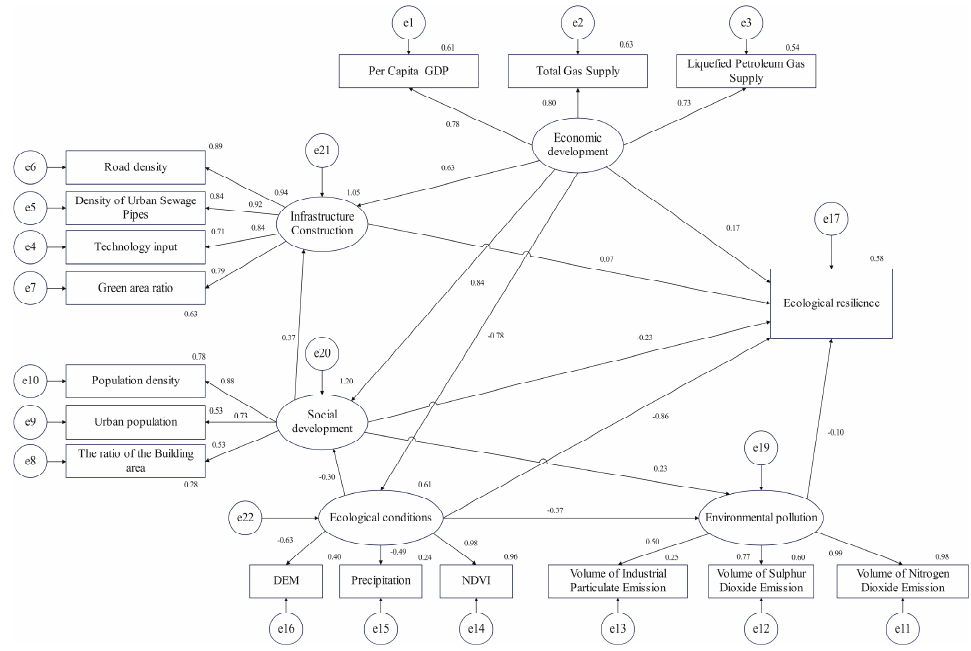
Figure 6. Driving factors analysis of ecological resilience in the YREBML based on SEM. Table 5. SEM path coefficients for the identification of key driving factors of ecological resilience in the YREBML.